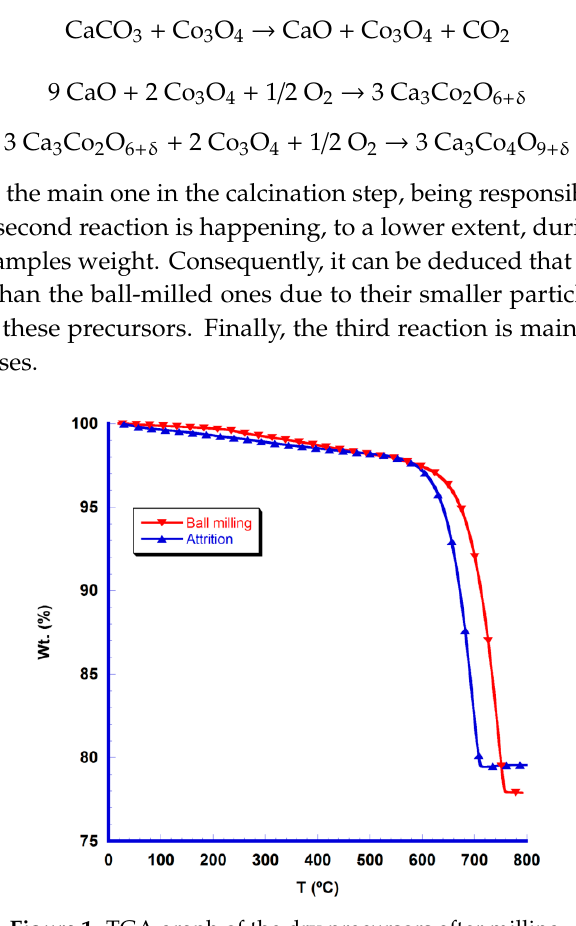
Figure 1. TGA graph of the dry precursors after milling.